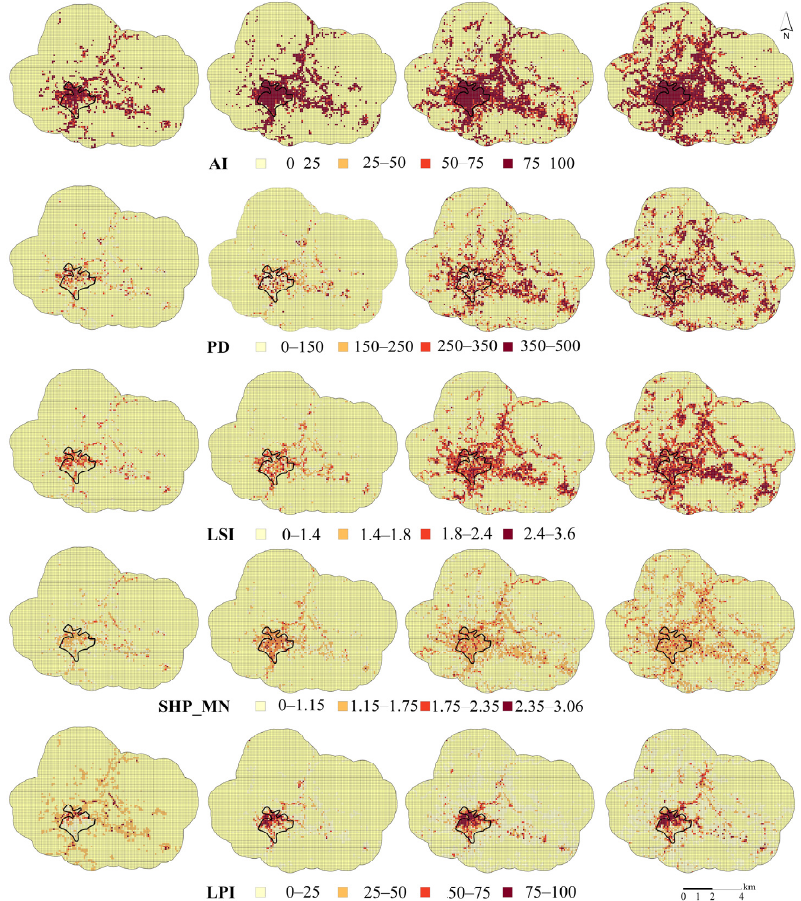
Figure 7. Spatiotemporal evolution of selected landscape metrics at 250 m cell size in 2002, 2010, 2016, and 2019 in Pithoragarh.